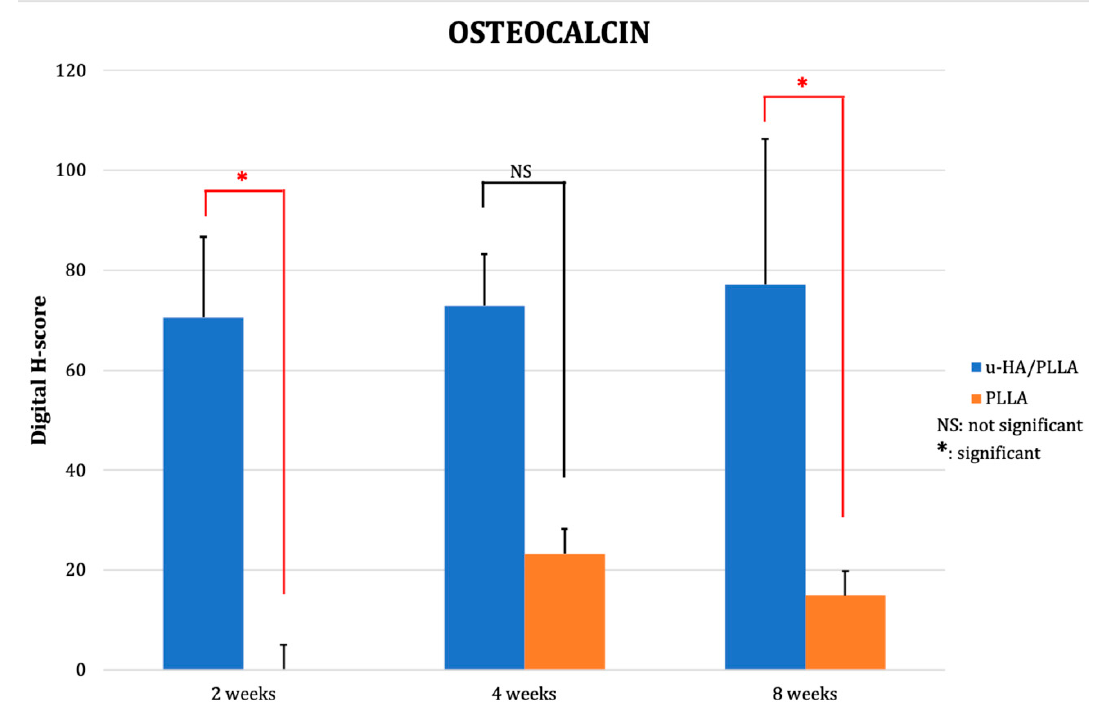
Figure 9. The mean digital H-scores based on immunohistochemical staining with anti-OCN antibody for the u-HA / PLLA and PLLA groups at weeks 2, 4, and 8. At week 2, there was limited new bone formation in the u-HA / PLLA group, whereas no new bone was observed in the PLLA group. The expression of OCN in the u-HA / PLLA group remained relatively stable over time and was significantly higher than in the PLLA group at week 8. * p <